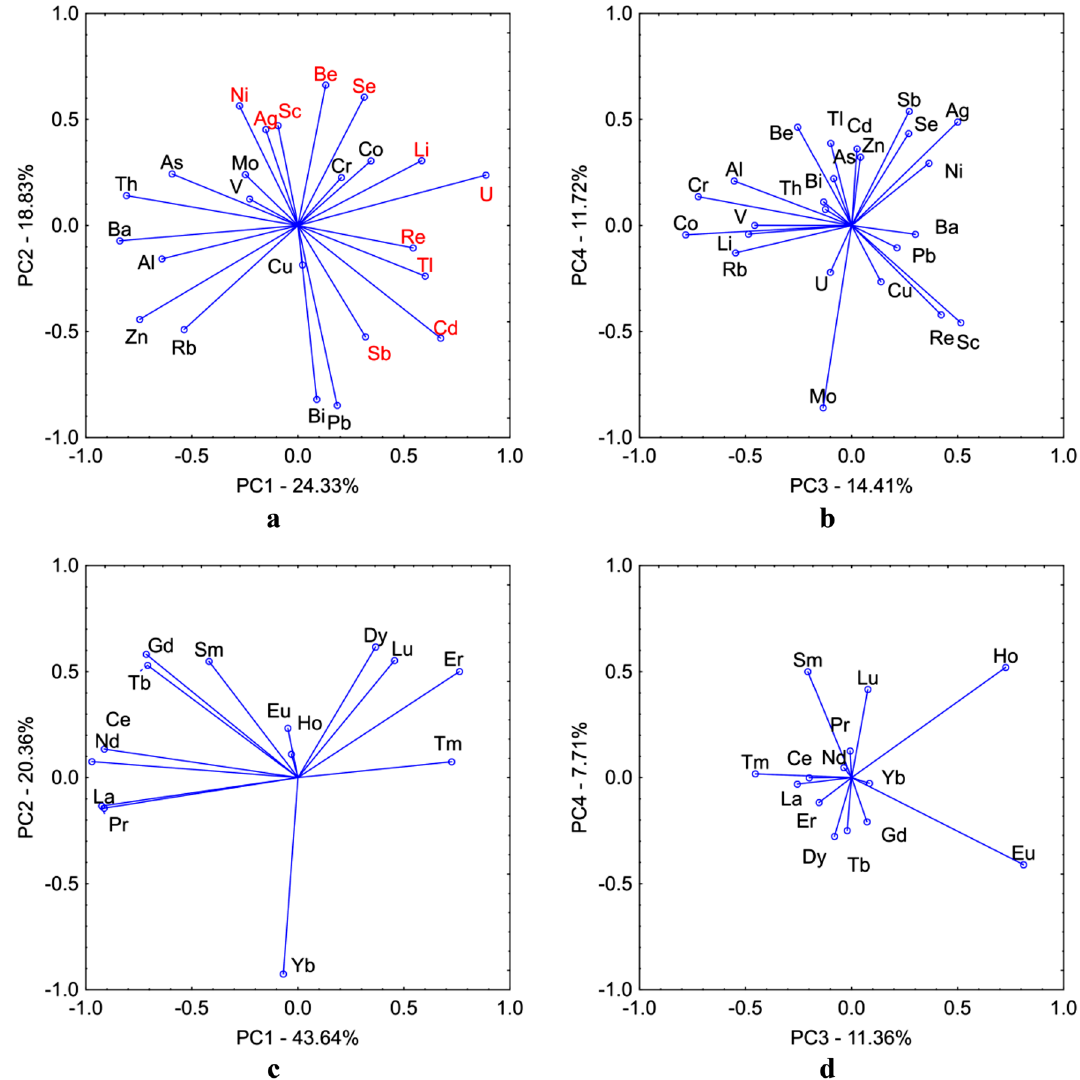
Figure 7. The results of PCA analysis for TEs PC1 vs. PC2 ( a ), PC3 vs. PC4 ( b ) and for REEs PC1 vs. PC2 ( c ), PC3 vs. PC4 ( d ). Figure generated in Canoco 5.0 (http://www.micro compu terpo